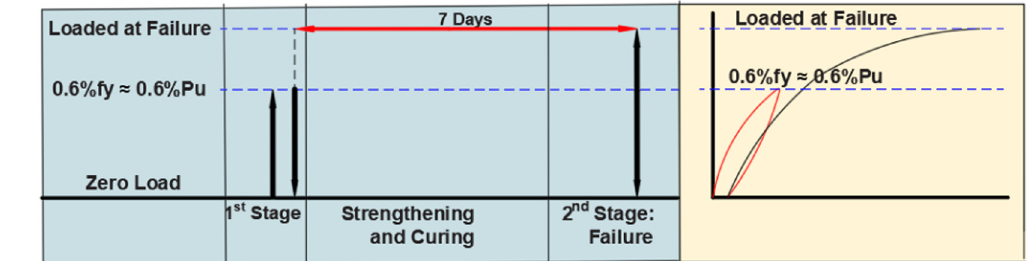
Figure 7: Typical loading